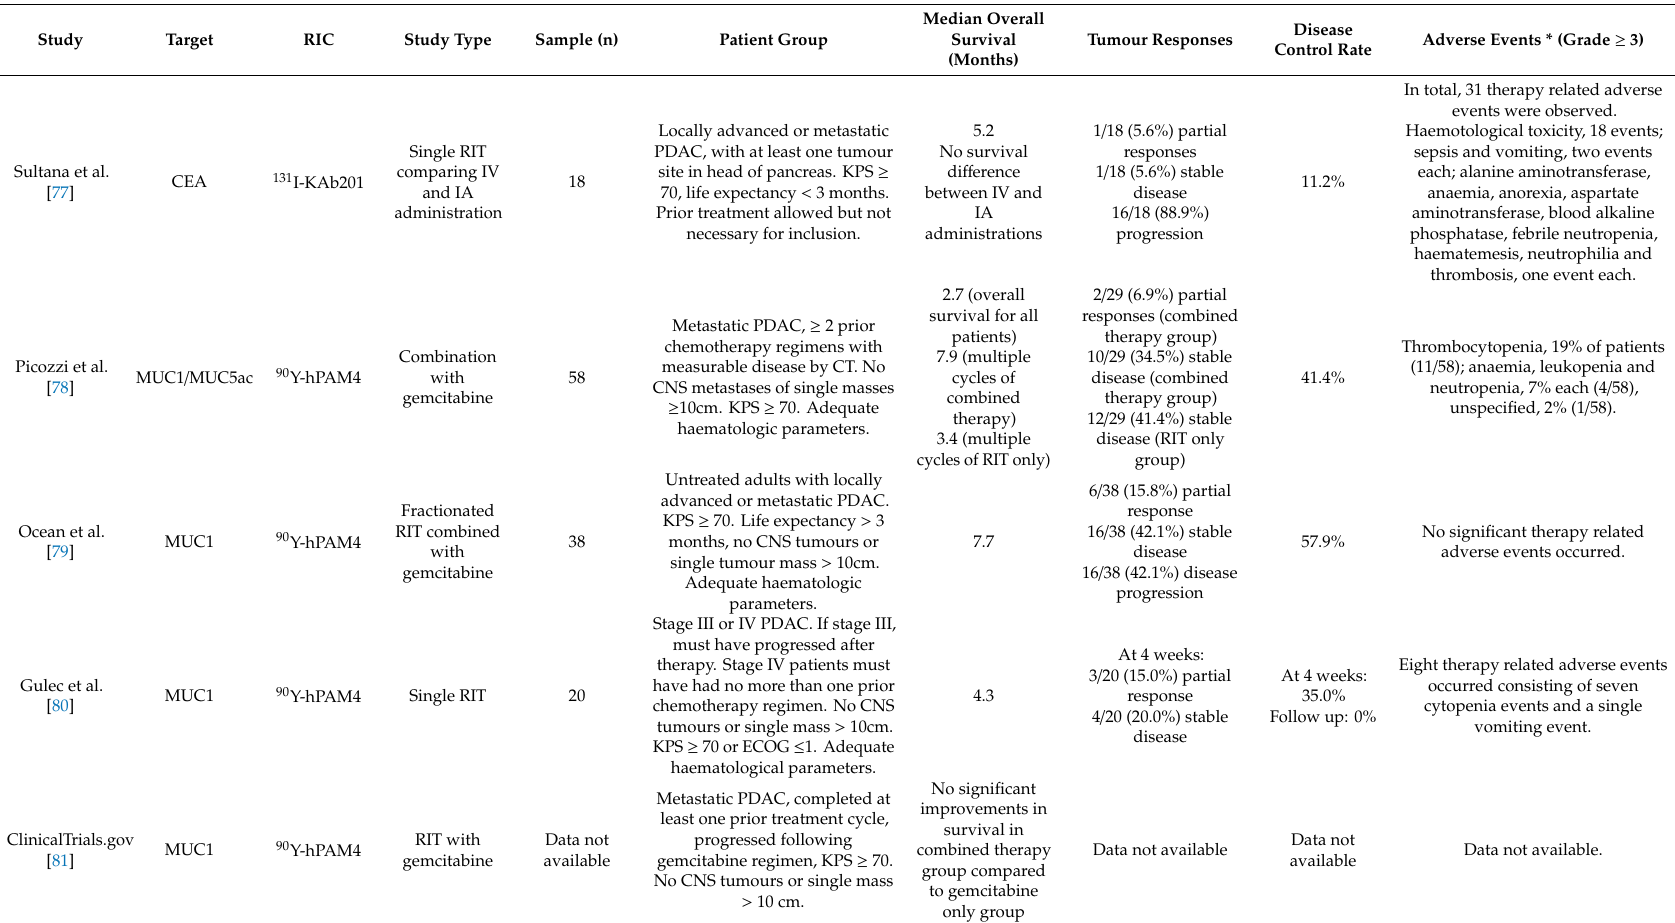
Table 5. Summary of clinical trials performed investigating β RIT in